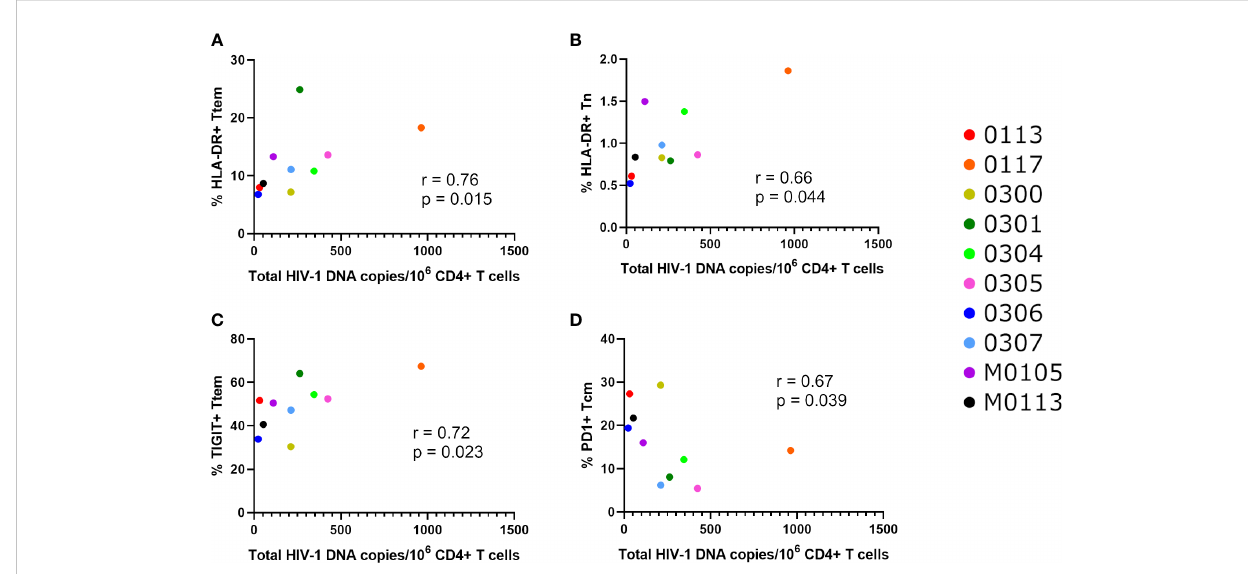
FIGURE 5 Signi fi cant correlations between total HIV-1 DNA and activation or exhaustion markers. Signi fi cant correlations between total HIV-1 DNA copies per million CD4+ T cells and the percentage of (A) Ttem cells expressing HLA-DR, (B) Tn cells expressing HLA-DR, (C) Ttem cells expressing TIGIT and (D) Tcm cells expressing PD1, as determined using Spearman ’ s correlation test, at